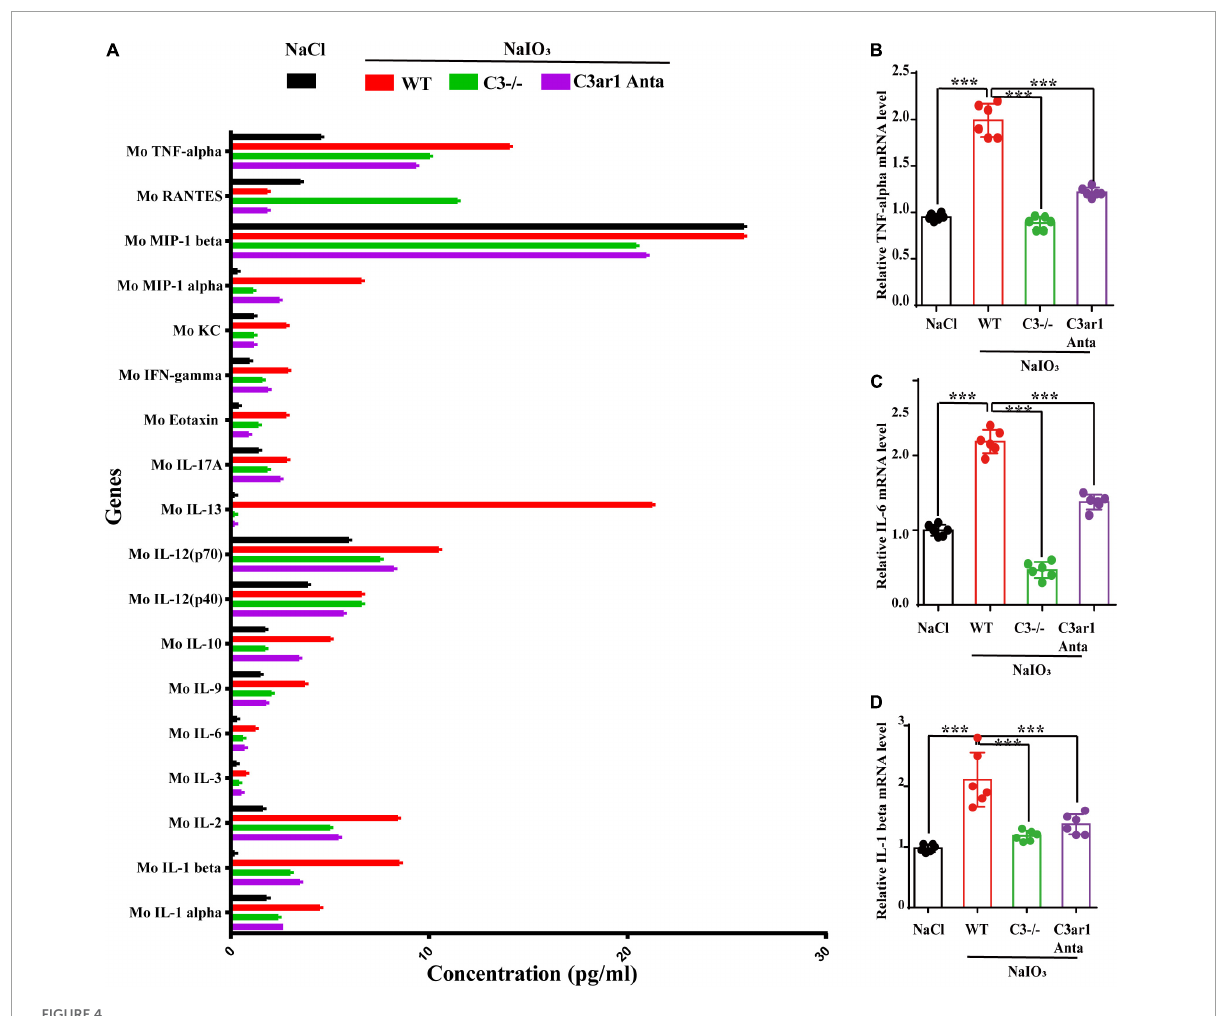
FIGURE4 Cytokine retinal array analysis reveals high levels of proinflammatory factors. (A) Clustered column graph of the retinal cytokine profiles of saline control- and NaIO3-treated WT, C3-KO and C3ar1-inhibited mice obtained by using the Integral Molecular@QAM-INF-1 kit. (B–D) The retinal Il-6, TNF- α and TGF- β 2 mRNA expression levels were determined by qRT–PCR. Each bar corresponds to the mean ± SD . *** p <